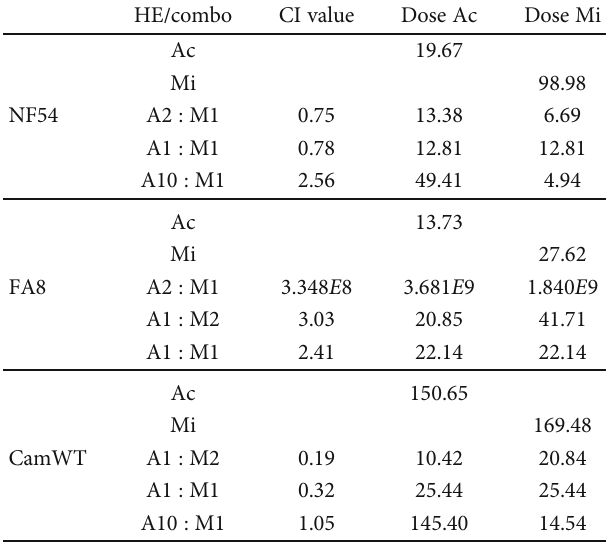
Table 2: The Compusyn drug combination estimated dose of A . cordifolia with M . indica on the three parasite